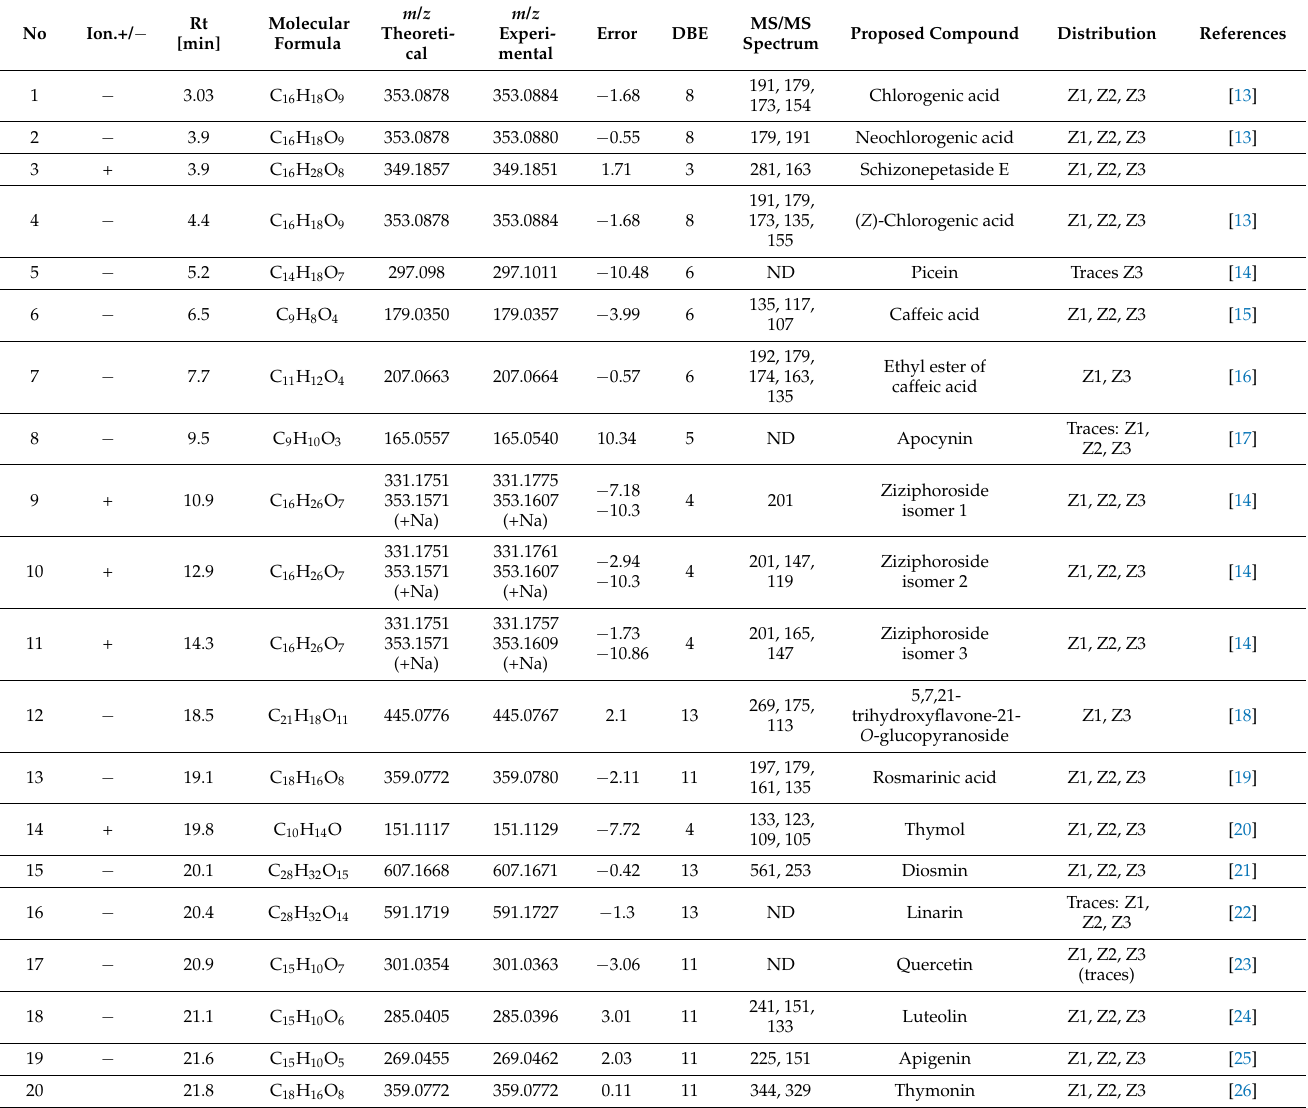
Table 1. The list of tentatively identified compounds present in the analyzed samples that were obtained from the HPLC-ESI-QTOF-MS/MS analysis in positive and negative ionization modes (DBE—double bond equivalent, error—error of measurement in ppm, Ion.—ionisation type, Rt—retention